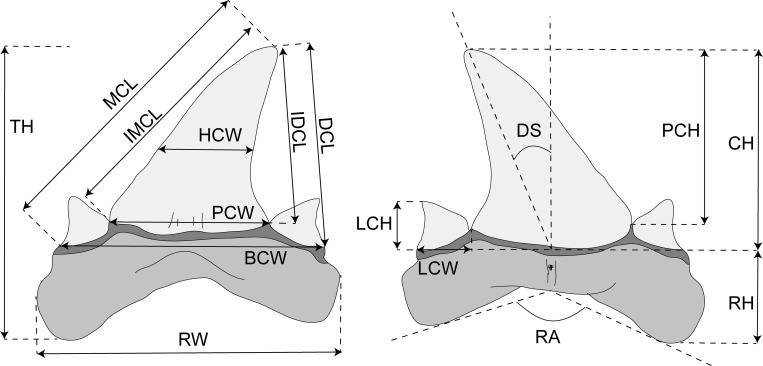
Morphometric tooth terminology.Abbreviations: BCW, basal crown width; CH, crown height; DCL, distal crown edge length; DS, degree of slant; IDCL, internal distal cutting edge length (cusp only); IMCL, internal mesial cutting edge length (cusp only); LCH, height of lateral cusplets; MCL, mesial crown edge length; PCH, height of principle cusp; PCW, width of principle cusp; RA, angle between root lobes; RH, root height; RW, root width; TH, total height of tooth.